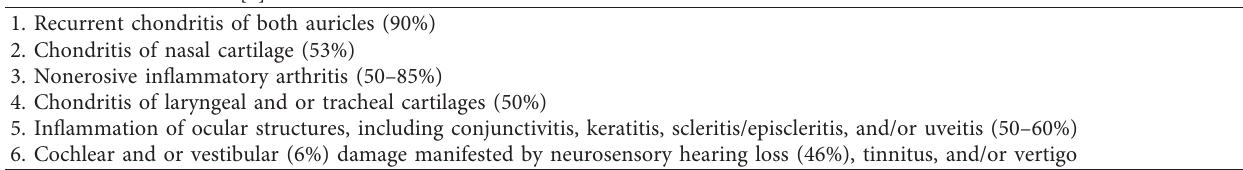
Table 1: Diagnostic criteria for RP according to McAdam et al. [9], and the observed frequencies of clinical presentation in patients, during the course of the disease